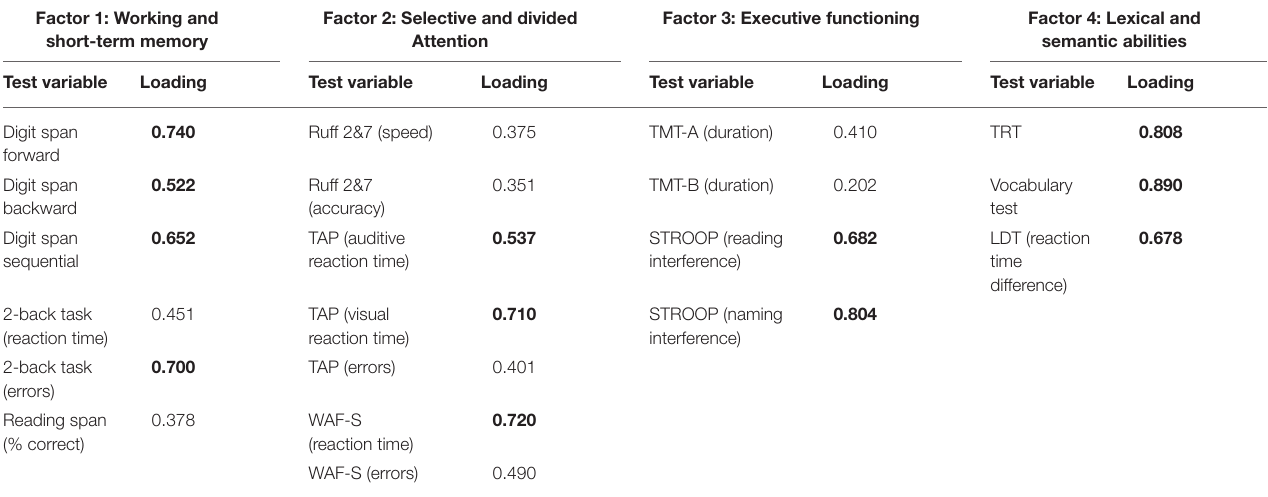
TABLE 3 | Factor loadings for each variable included in the confirmatory PCA. Factor 1: Working and Factor 2: Selective and divided Factor 3: Executive functioning Factor 4: Lexical and short-term memory Attention